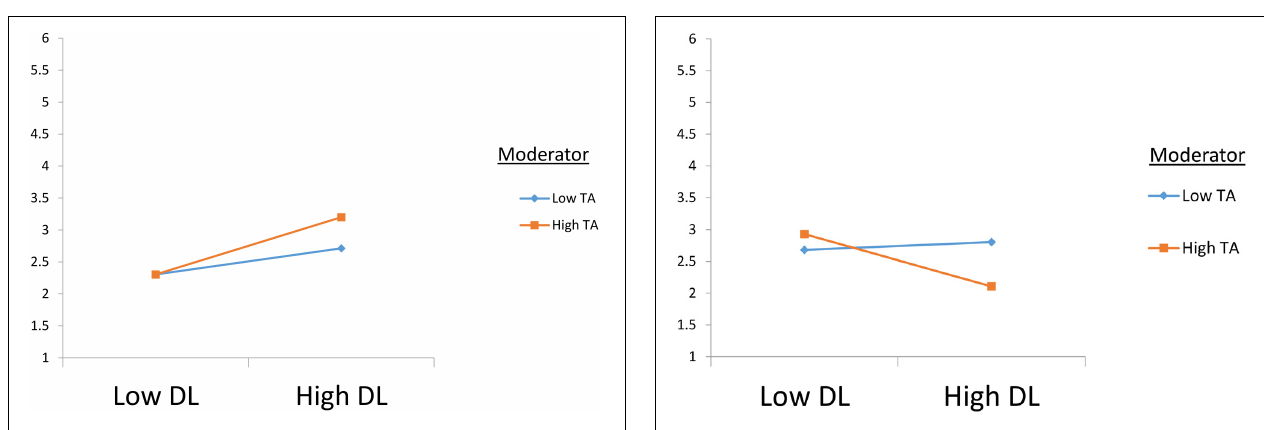
FIGURE 4 | Interaction plot for life satisfaction. DL, Despotic Leadership; TA, Trait Anxiety; LS, Life Satisfaction. N =